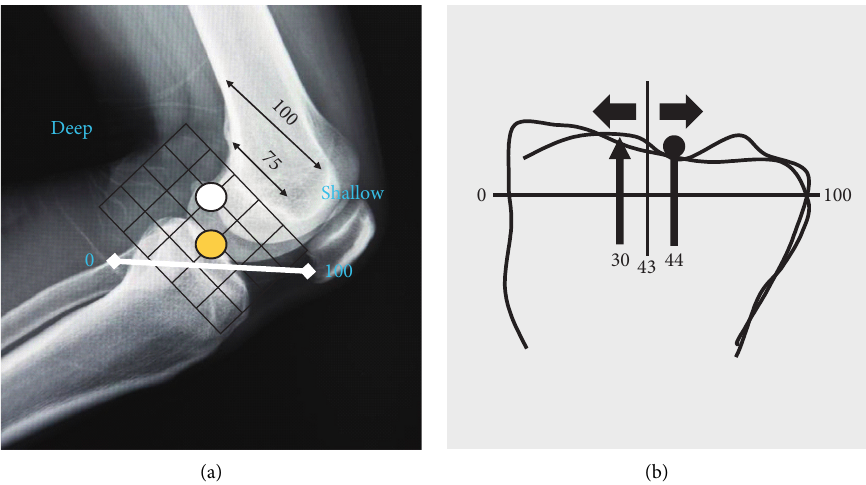
Figure 2: The ideal tibial bone tunnel positions for the secondary injury after anterior cruciate ligament rupture.